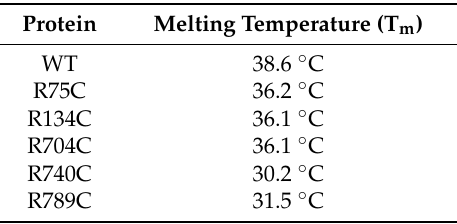
Figure 2. CD spectra and melting curves of purified collagen II variants. ( A ) Spectra were recorded using collagens at a concentration of 60 µg/mL after dialysis against 100 mM acetic acid. The structure of the mutant collagen II proteins R740C and R789C was altered as compared to other collagen II variants, and the shape of the spectra already indicated a decrease in triple helical structure. ( B ) Melting curves of collagen II proteins (60 µg/mL) were recorded after dialysis into 100 mM acetic acid at 222 nm with a 1 °C/min temperature gradient from 10–55 °C. To calculate the percentage of folding, a curve fit model was used assuming that initially 100% of the collagen molecules were folded. The R740C and R789C proteins displayed a decreased thermal stability when compared to all other collagen II variants. Table 1. Melting temperatures (Tm) of the purified collagen II variants.